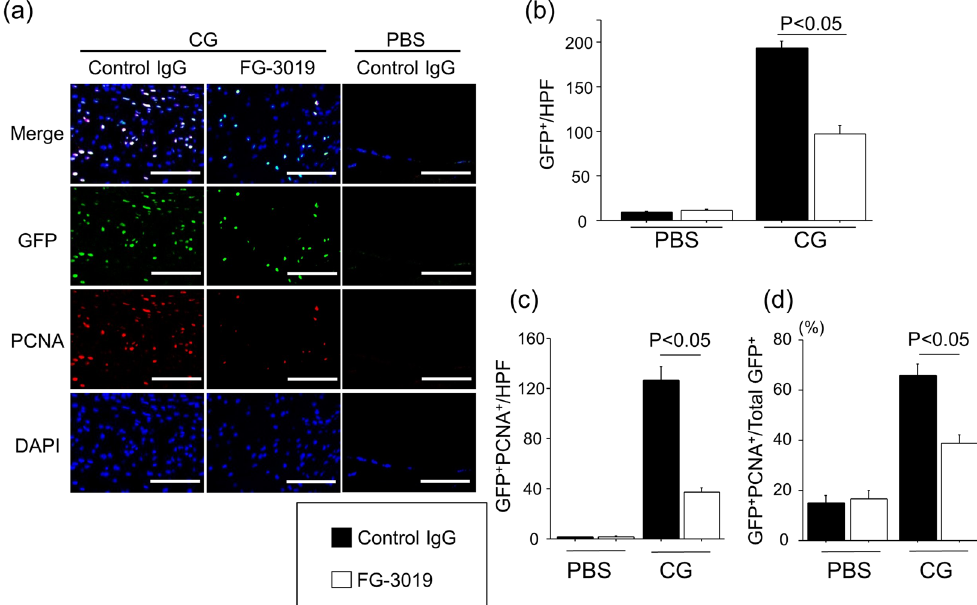
Figure 2. CG-induced peritoneal fibroblast accumulation and proliferation is dependent on CTGF. ( a ) Accumulation of proliferating fibroblasts (GFP + PCNA + ). Peritoneal sections at day 21 were obtained from mice treated with control IgG or FG-3019. Representative tissue sections stained with anti-GFP antibody (green)/anti-PCNA antibody (red) are shown. Bars, 50 μ m. ( b ) Numbers of GFP + cells in the peritoneum are expressed as the mean number ± SEM per HPF (n = 5 mice/group). ( c ) Numbers of peritoneal GFP + PCNA + cells (proliferating fibroblasts) are expressed as mean number ± SEM per HPF. ( d ) Percentages of